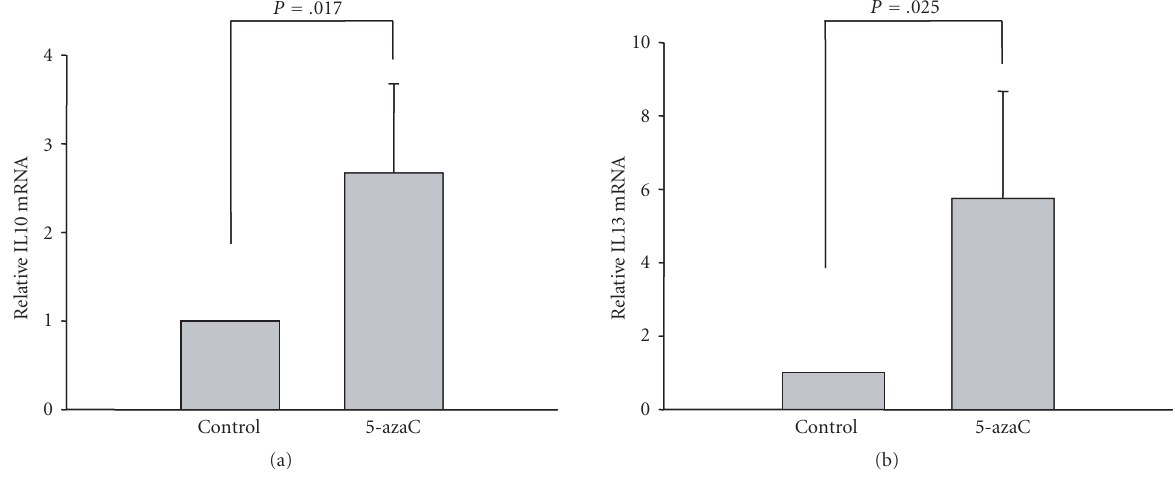
Figure 5: Treatment of healthy CD4 + T cells with 5-azaC promotes IL10 and IL13 mRNA transcription. mRNA expression levels of IL10 (a) and IL13 (b) were measured by quantitative real-time PCR and normalized to β -actin . Treatment with 5-azaC results in a 2.6-fold increase of IL10 and a 5.7-fold increase of IL13 , relative to untreated controls ( P = . 017 and P = . 025,